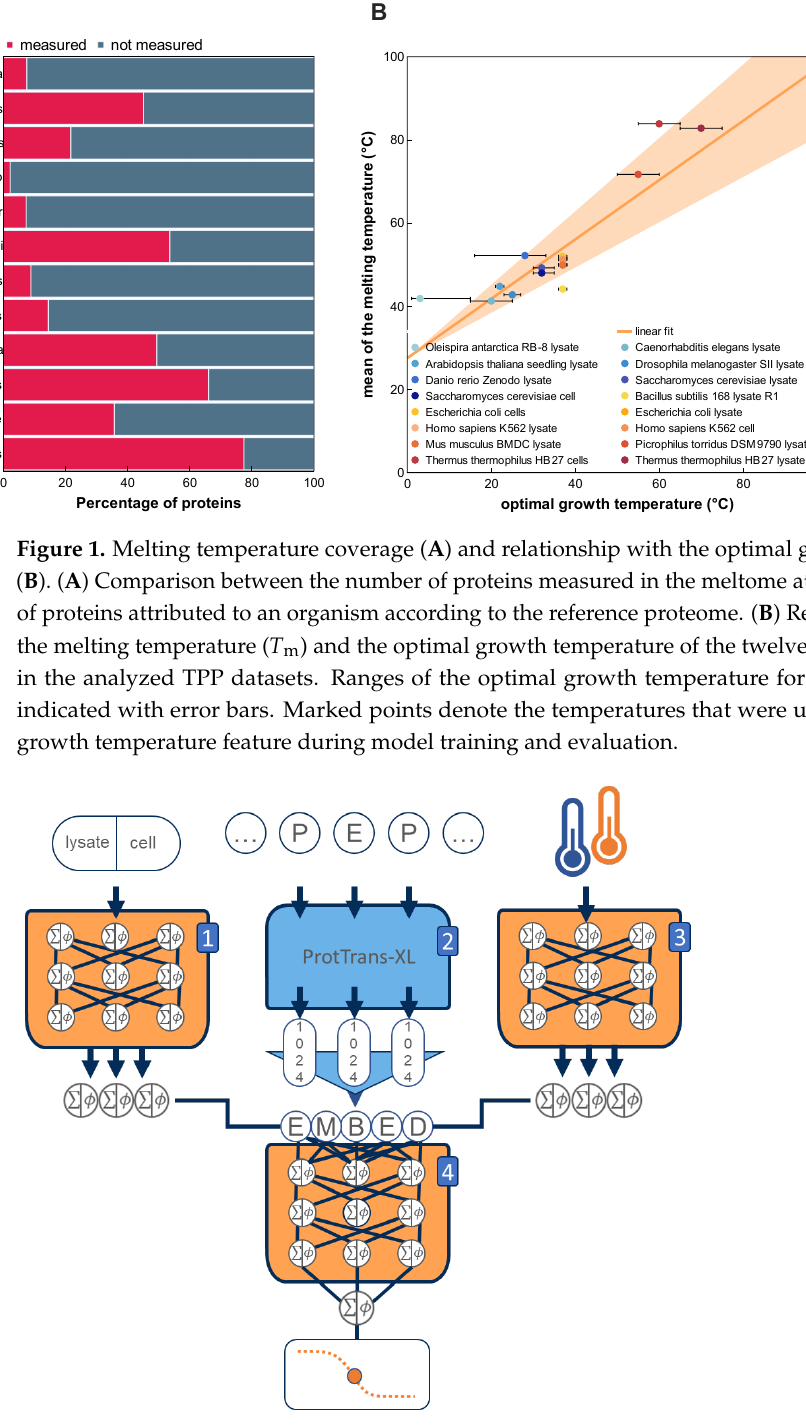
Figure 2 . Schematic overview of the deep learning architecture DeepSTABp trained to predict pro- tein melting temperatures. The proposed model is based on four different artificial network blocks. The first three blocks are responsible of creating an embedding of the protein query based on the input features, (1) type of experimental condition used in the thermal proteome profiling experi- ment, (2) the protein amino acid sequence and (3) the organism growth temperature. While Blocks 1 and 3 use small multilayer perceptrons (MLP), Block 3 consists of the pretrained transformer- based model ProtTrans-XL, followed by a mean pooling layer. The output vectors of the first blocks are concatenated and then used as inputs for a (4) final MLP block, whose output is the predicted protein T m